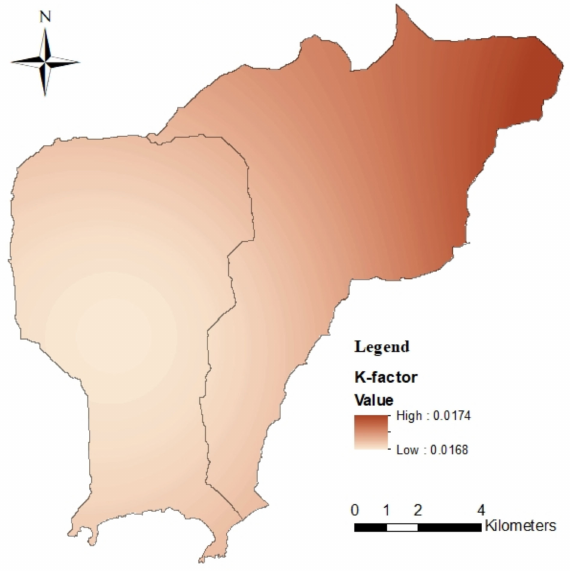
Figure 7. K-factor